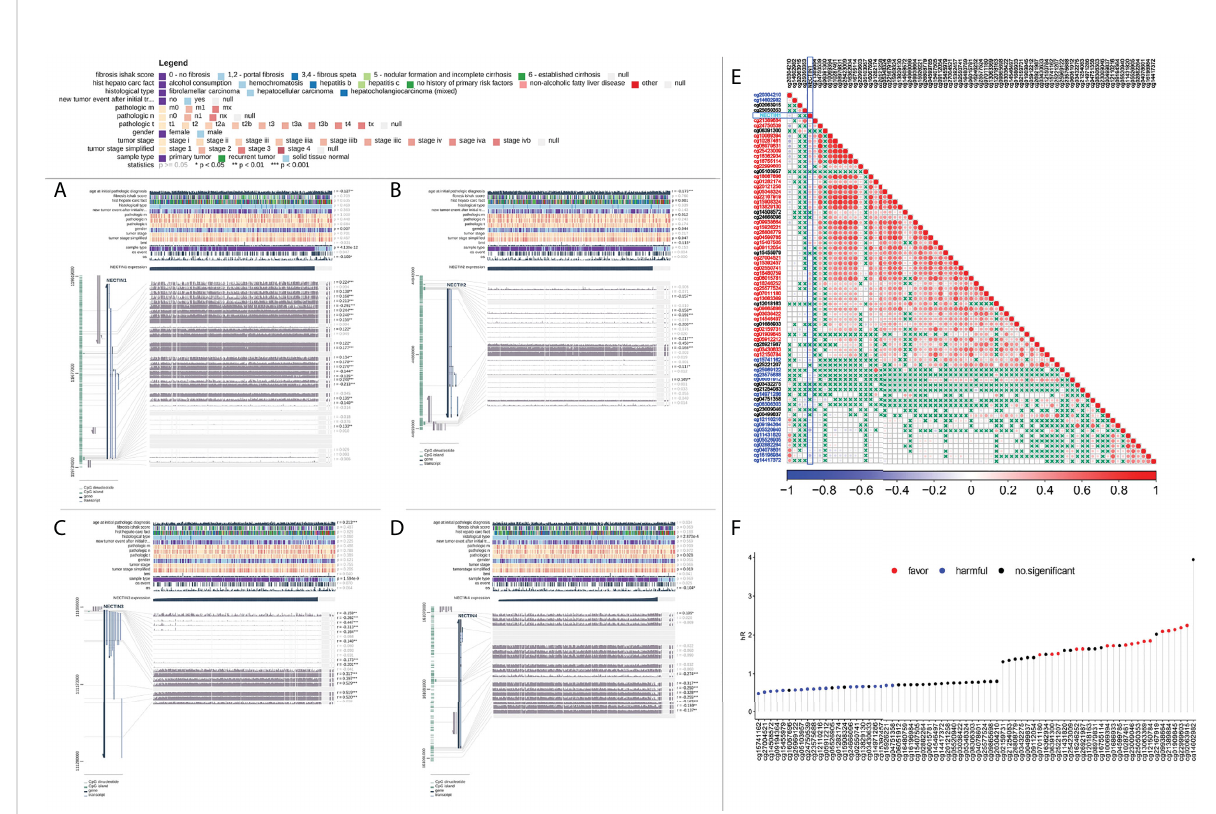
FIGURE 4 Analysis of DNA methylation of nectin-1, nectin-2, nectin-3, and nectin-4 genes and prognosis of HCC. (A) DNA methylation of nectin-1 by MEXPRESS. (B) DNA methylation of nectin-2 by MEXPRESS. (C) DNA methylation of nectin-3 by MEXPRESS. (D) DNA methylation of nectin-4 by MEXPRESS. (E) Correlation between nectin-1 gene expression and methylation sites. (F) Correlation between methylation sites of nectin-1 gene and OS of patients with HCC.